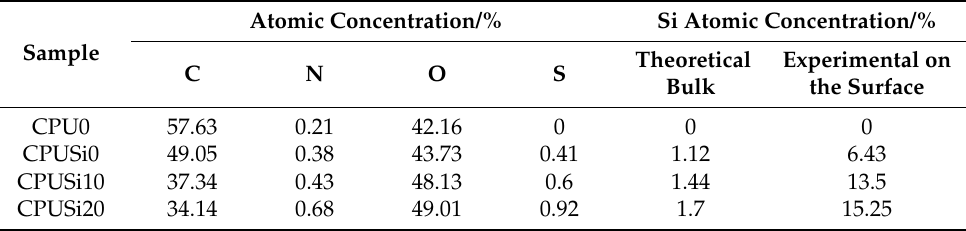
Table 2. XPS peak characteristics of CPU0, CPUSi0, CPUSi10, and CPUSi20.